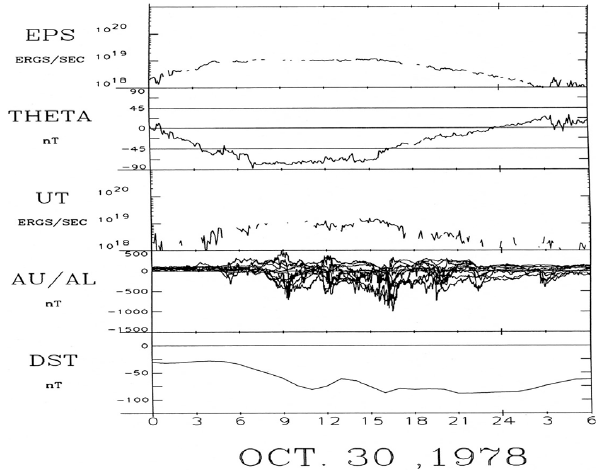
Fig. 6. An example of geomagnetic storm in which a high power ε is almost constantly maintained for about 12h. Several substorms occurred successively during the